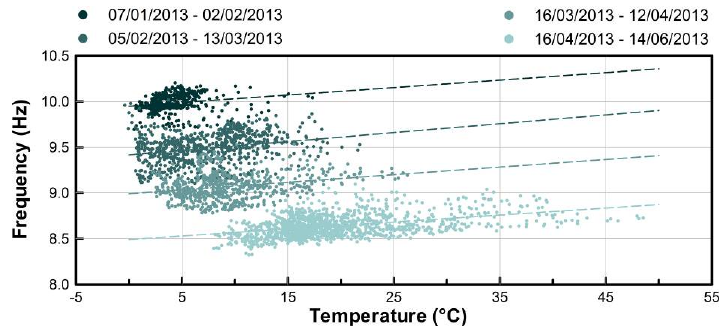
Figure 10. Natural frequency of local mode L 1 plotted vs. temperature in the period between 07/01/2013 and 14/06/2013.